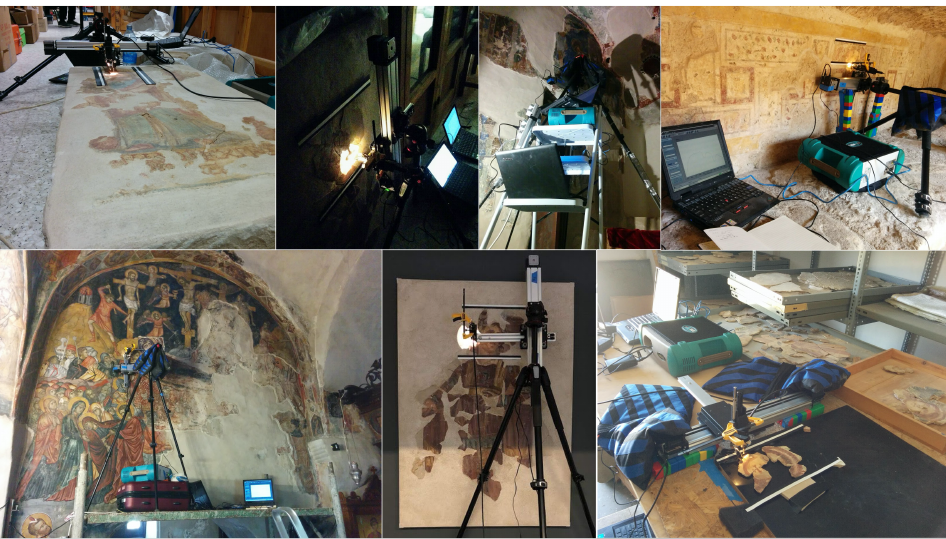
Figure 10. The SRS hyperspectral system was applied in various locations in/near Paphos, Cyprus, including ancient tombs, religious spaces, museum galleries and laboratories, and field